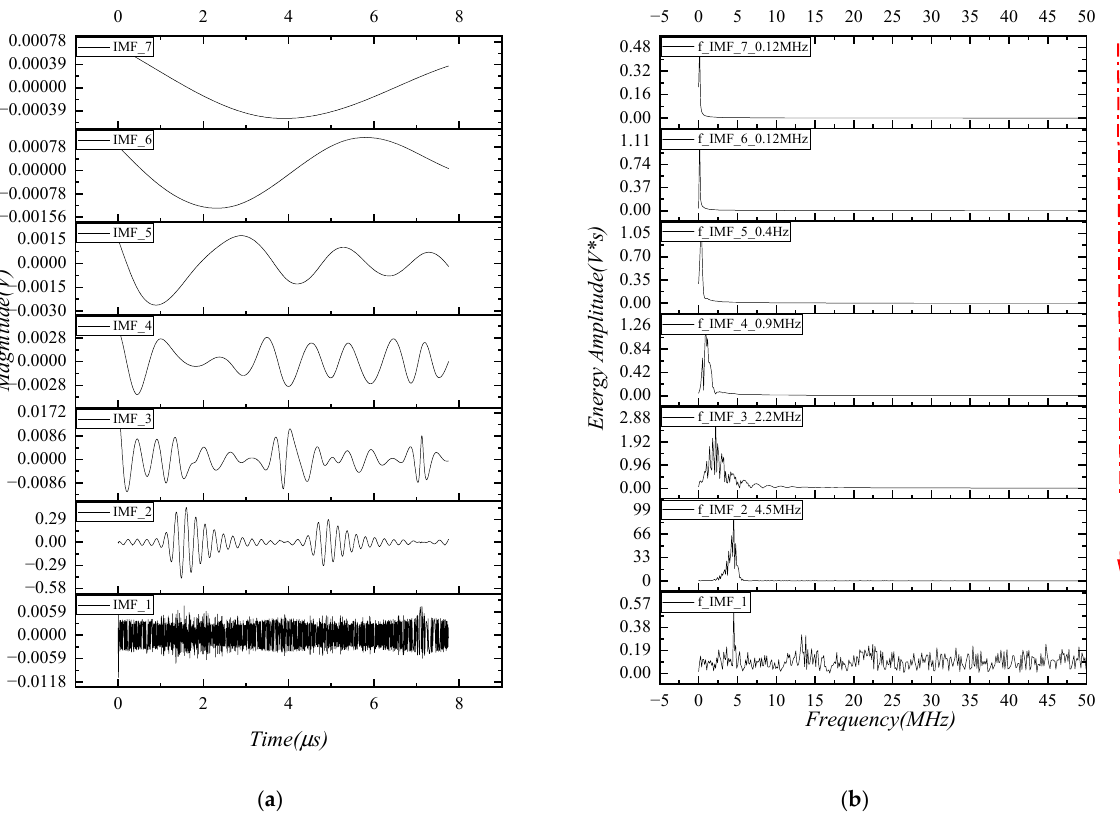
Figure 8. ( a ) IMF results of a representative ultrasonic echo signal acquired with a 304SS sample, and ( b ) the corresponding frequency spectra(Frequency increases as the red line).